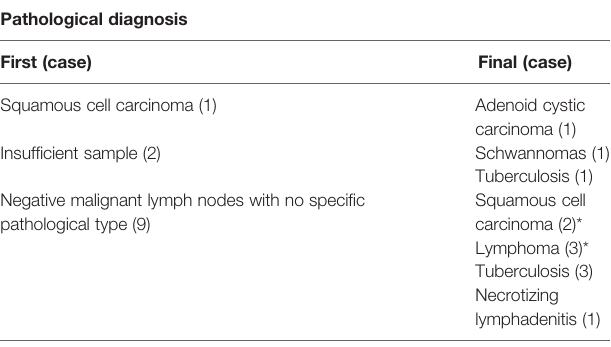
TABLE 3 | Pathological diagnosis of patients undergoing a second biopsy in the FNA group. Pathological